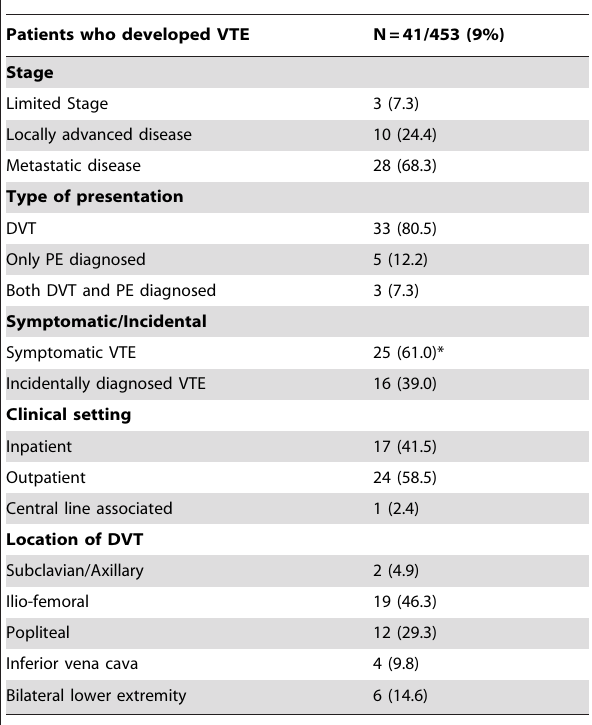
Table 2. Characteristics of patients with VTE.